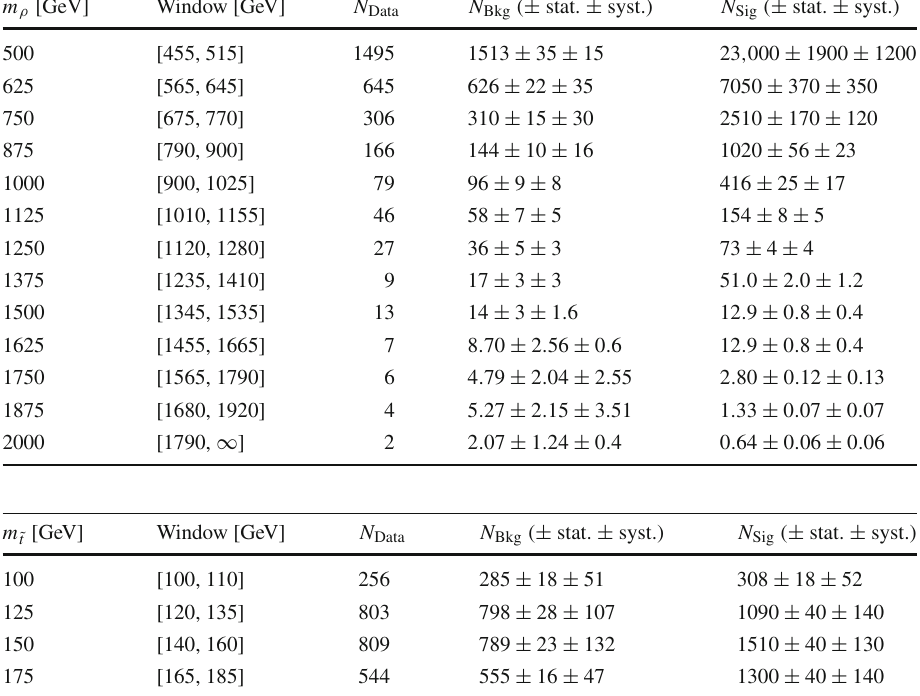
events in the data, N Data , the estimated numbers of background events, N Bkg , and the expected numbers of top squark signal events, N Sig , in the top squark mass windows of the b -tagged signal region. Separate statistical and systematic uncertainties are